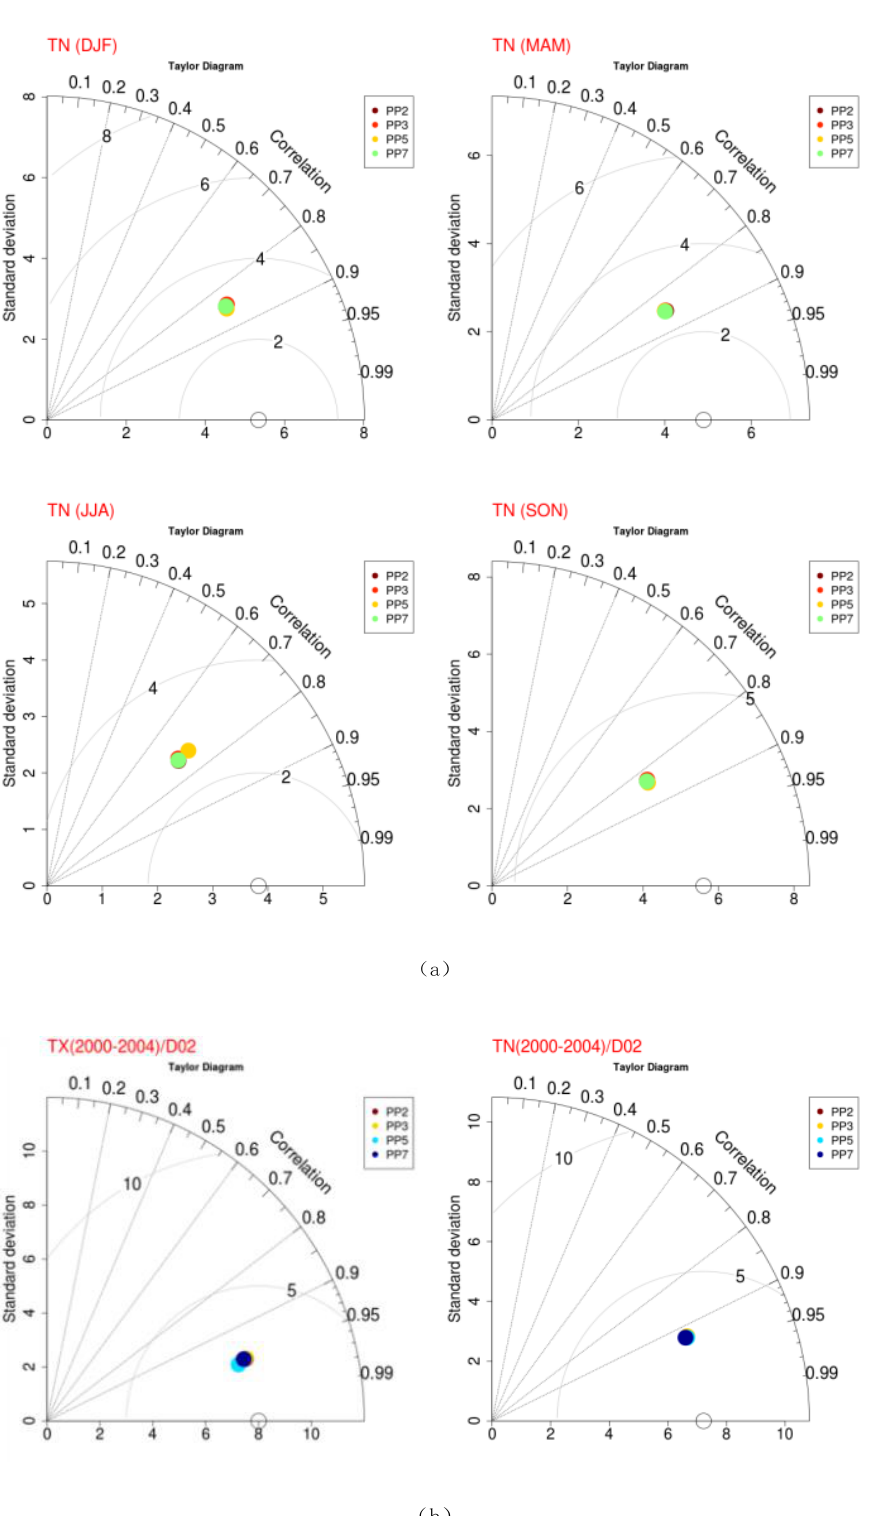
Figure 7. ( a )Seasonal Taylor diagrams of the four WRF simulations (PP2, PP3, PP5, PP7) with respect to observed daily maximum (TX) and minimum temperatures (TN) for the high-resolution domain of Greece (D02). ( b ) Annual Taylor diagrams of the four WRF simulations (PP2, PP3, PP5, PP7) with respect to observed daily maximum (TX) and minimum temperatures (TN) for the high-resolution domain of Greece